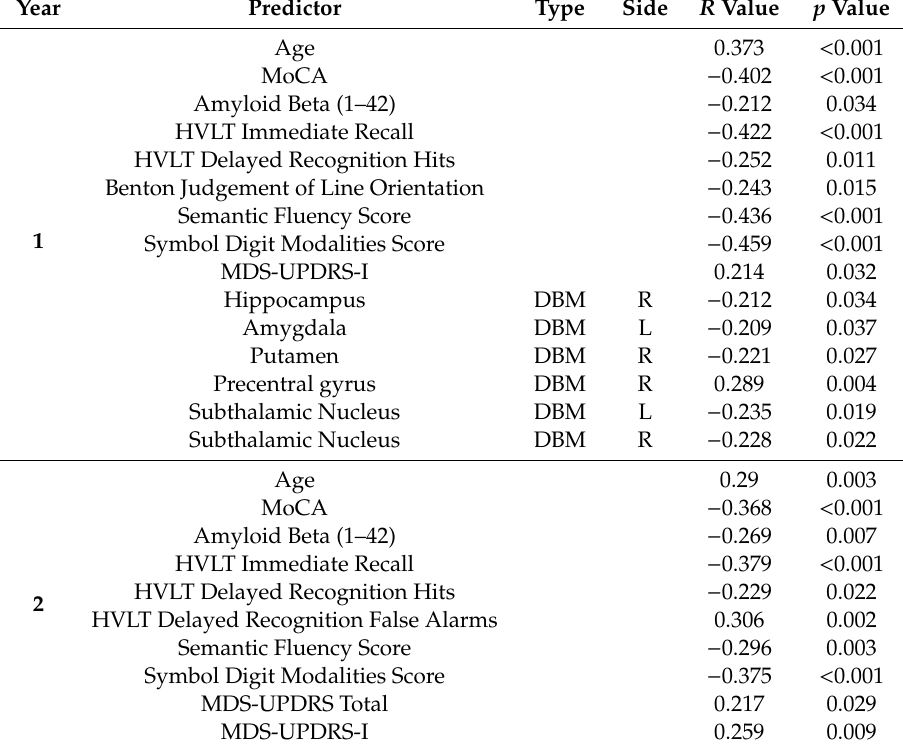
Table 2. MoCA Spearman’s rank correlation coe ffi cients of only baseline predictors at four time points past